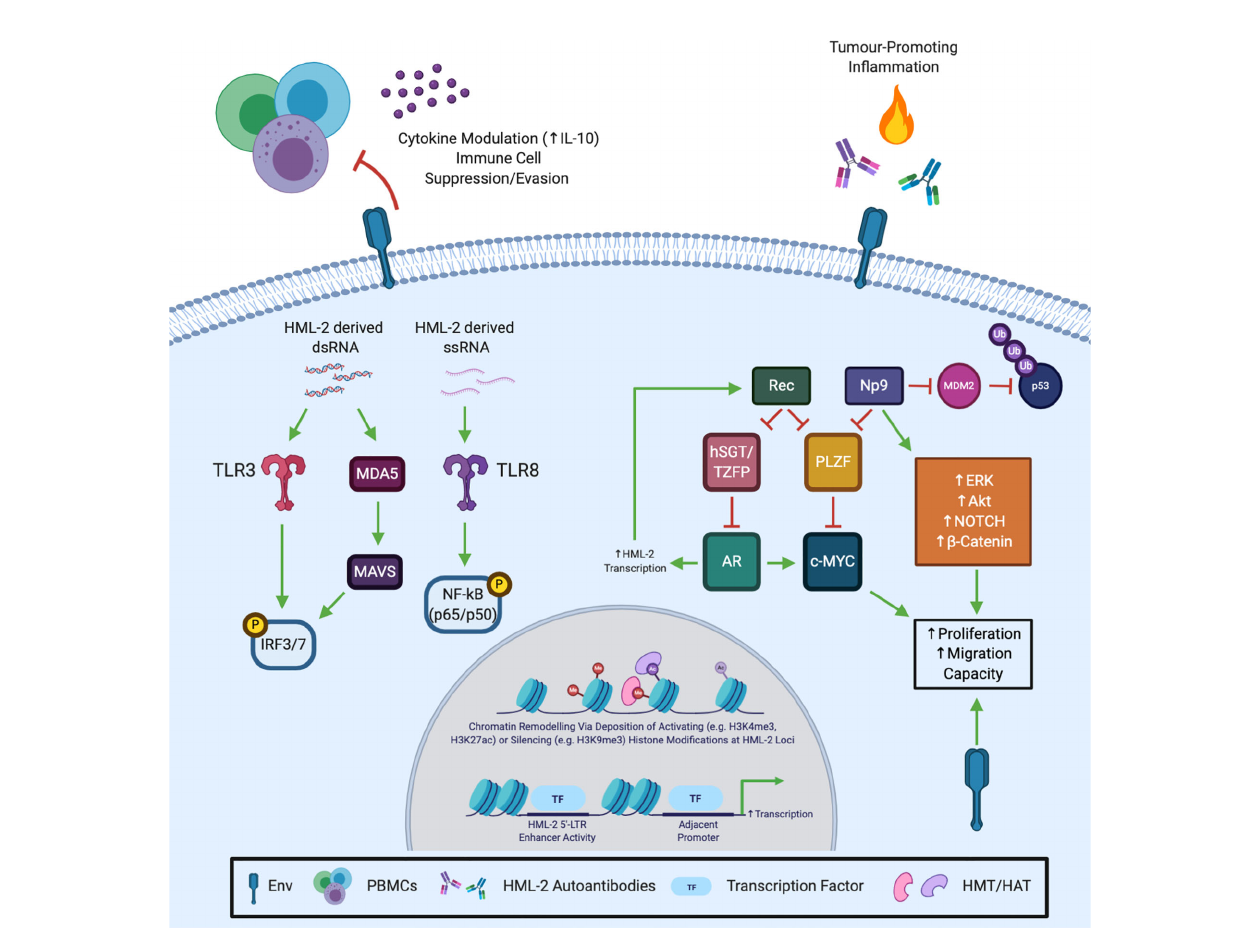
FIGURE 2 | Potential Mechanisms and Molecular Underpinnings of HML-2 Induced Oncogenesis/Tumour Promotion. HML-2 Gag and Env are known to be immunogenic and may contribute to chronic tumour-promoting in fl ammation. In addition, HML-2 ssRNA binds and activates Toll-like receptor 8 (TLR8), while HML-2 and other HERV-derived dsRNAs may activate Toll-like receptor 3 (TLR3) and the melanoma differentiation-associated protein 5 (MDA5)/mitochondrial antiviral signalling protein (MAVS) pathway to elicit a type I IFN response and nuclear factor - k B (NF- k B) activation. Conversely, Env has been shown to possess an immunosuppressive domain and may inhibit peripheral blood mononuclear cell (PBMC) activation via interleukin-10 (IL-10) to aid tumour immune escape. Rec inhibits the androgen receptor (AR) repressor proteins human small glutamine-rich tetratricopeptide repeat (hSGT) and testicular zinc fi nger protein (TZFP), potentially forming a positive feedforward loop driving chronic HML-2 transcription and AR activation. Np9 has been shown to activate multiple oncogenic signalling pathways (including ERK, Akt, NOTCH and b -catenin), while both accessory proteins have been shown to induce c-Myc transcriptional derepression by inhibiting the promyelocytic leukaemia zinc fi nger protein (PLZF). Np9 can also bind and inhibit the E3 ubiquitin ligase mouse double minute 2 homolog (MDM2), however, the impact of the resultant p53 stabilisation would likely depend on p53 mutational status. Finally, HML-2 insertions may regulate neighbouring gene expression by (1) recruiting histone methyltransferases (HMT) or histone acetyltransferases (HAT) to regulate chromatin accessibility, or (2) serve as alternative enhancer regions that drive adjacent gene transcription. Created with